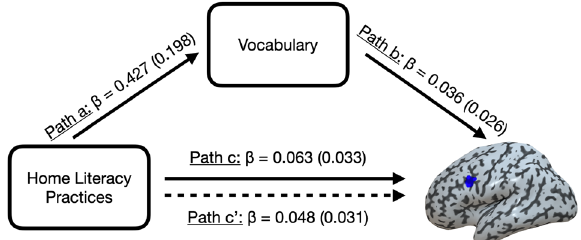
Fig. 6 Mediation analysis ( n = 44). The relation between home literacy practices and word adaptation in the pIFs was in fl uenced by vocabulary (see main text). The solid line from home literacy practices to word adaptation in the pIFs represents the total effect (Path c). The dotted line represents the direct effect (Path c ′ ). The analysis was controlled for parental income and education.